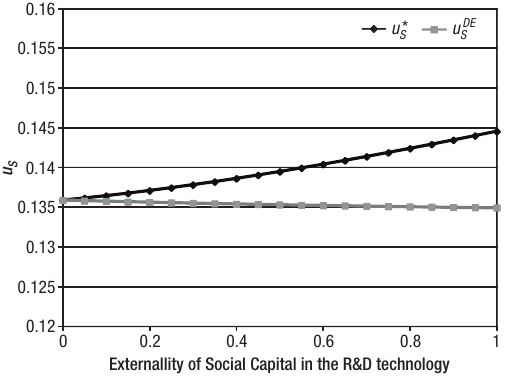
Fig. 5. Comparison between DE